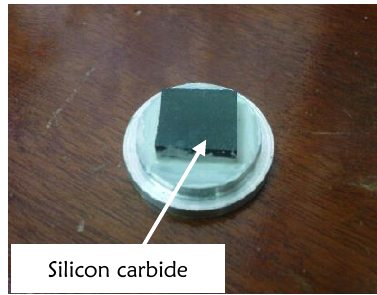
Silicon Figure 1: Silicon Carbide work-piece glued on an aluminum fixture.